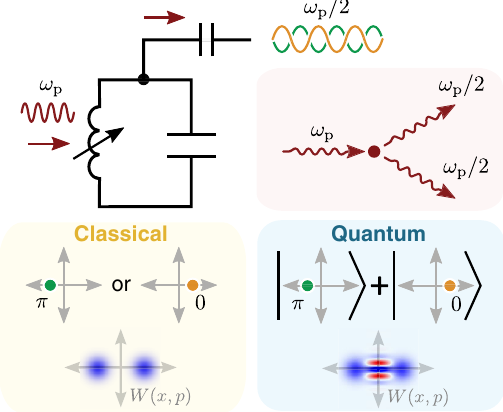
FIG. 1. Schematic of a parametric oscillator above the insta- bility threshold. An LC circuit with a harmonically modulated inductance is an example of a parametric oscillator. Above threshold, the system is oscillating at half the driving frequency ω = 2 , which can be described as a parametric down-conversion p process. The phase of the oscillator with respect to the external driving can be 0 or π . Classically, this symmetry is broken, and one of the two cases is realized at random. Quantum mechan- ically, the oscillator can be in a superposition of both